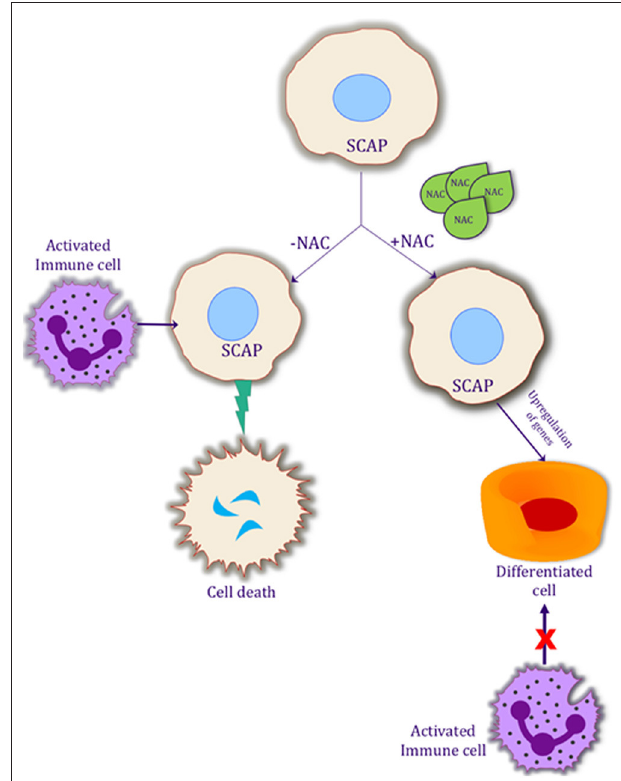
FIGURE 5 | Possible mechanism of action of NAC on SCAP differentiation and its interaction with the activated immune system. Schematic representation of the effects of NAC on SCAP. Differentiation of SCAP helps it to be more resilient to an activated immune system, which in turn could possibly help the procedure of regenerative